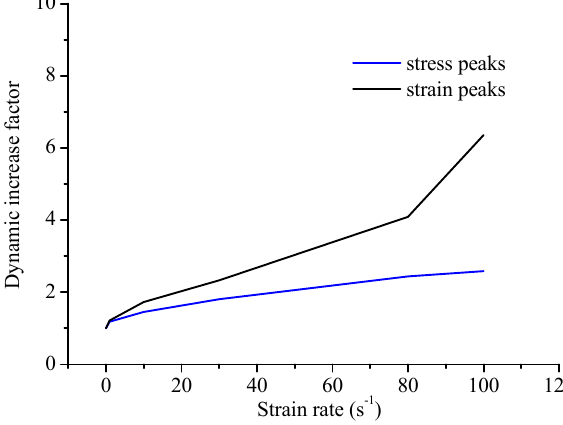
Figure 10. The comparison of the peak values of strain and stress.